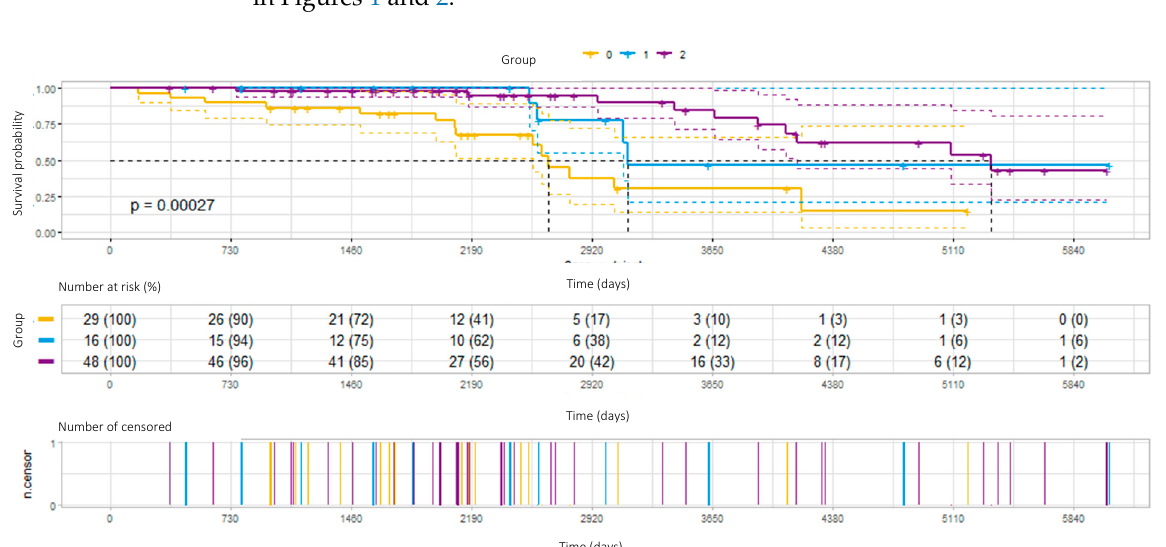
Fig. 1. Kaplan – Meier survival curves for different treatment outcome groups